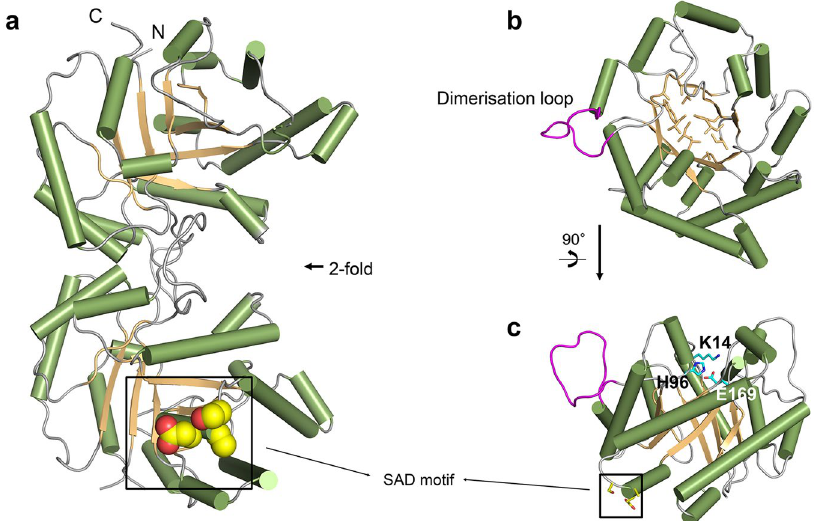
Figure 1. Overall structure of OvTIM. ( a ) Overall dimeric structure of OvTIM. The bundle of α -helices and β -barrel of OvTIM are represented as green and orange cartoon models, respectively. The SAD motif is denoted as a yellow sphere model. ( b ) The top view and ( c ) rotation view of the monomer of OvTIM are displayed. Hydrophobic residues forming the β -barrel fold are represented as a stick model. The catalytic triad, SAD motif, and dimerization loop are highlighted as cyan, yellow , and magenta ,